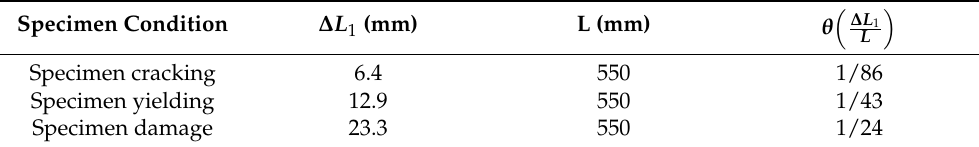
Table 10. Displacement angle of specimen